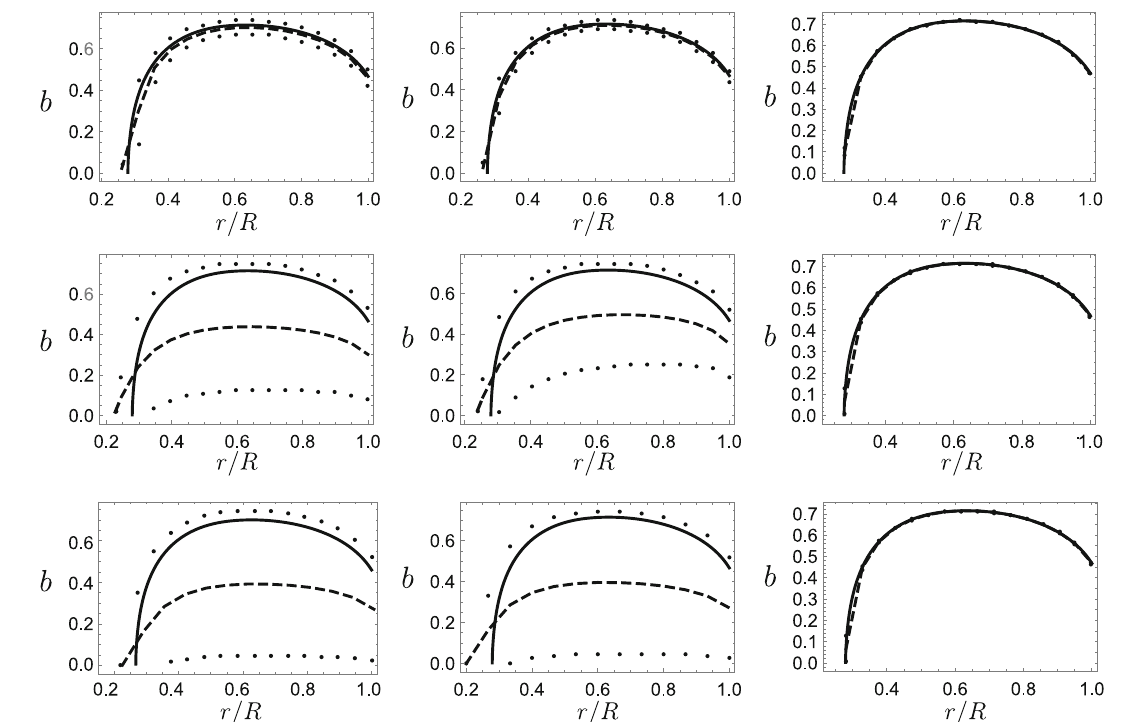
and the points below it are those for co-rotating directions. The first column is for θ = π/ 2, the second is for θ = π/ 4 and the last is for θ = 1 / 100. The first row is for j = 0 . 1, the second is for j = 0 . 4 and the last is for j = 0 .